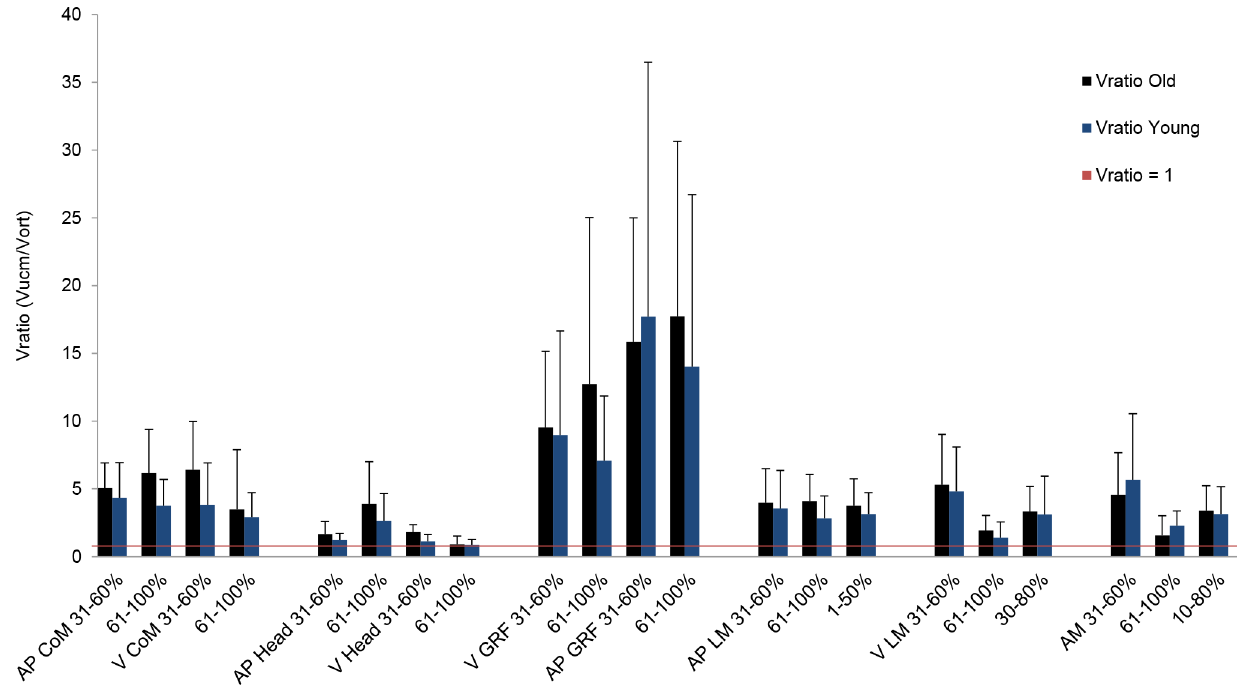
Figure 2. V RATIO for old and young participants. V RATIO of all performance variables for young and old participants in the anterior-posterior and vertical dimension of the CoM, head, GRF and linear momentum and for the angular momentum. V RATIO of the CoM, head and GRF is given for lift-off (31–60%) and the extension phase (61–100%) of the chair rise. V RATIO of the linear and angular momentum is given for lift-off, extension phase and the phases where greatest momentum change (0–50%; 30–80% and 10–80%) occurred. AP: anterior-posterior. V: vertical. LM: linear momentum. AM: angular momentum. Error bars represent standard error of the mean.